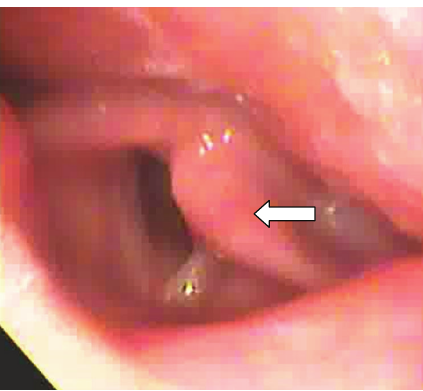
Figure 1: Left vocal fold fixed in abduction during respiration.